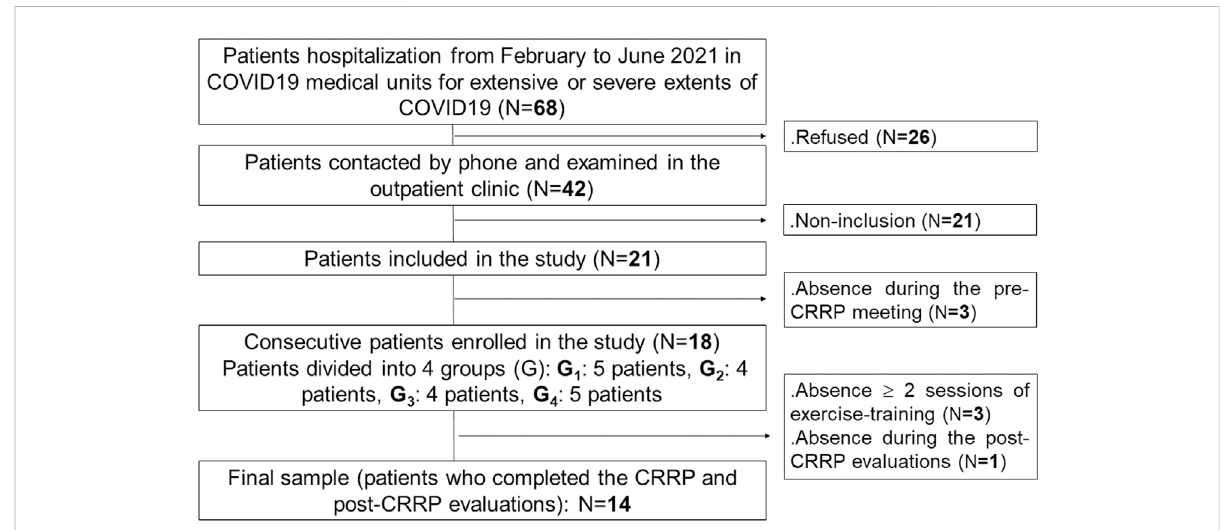
FIGURE 1 Study protocol. COVID19: coronavirus disease 2019. CRRP, cardio-respiratory rehabilitation